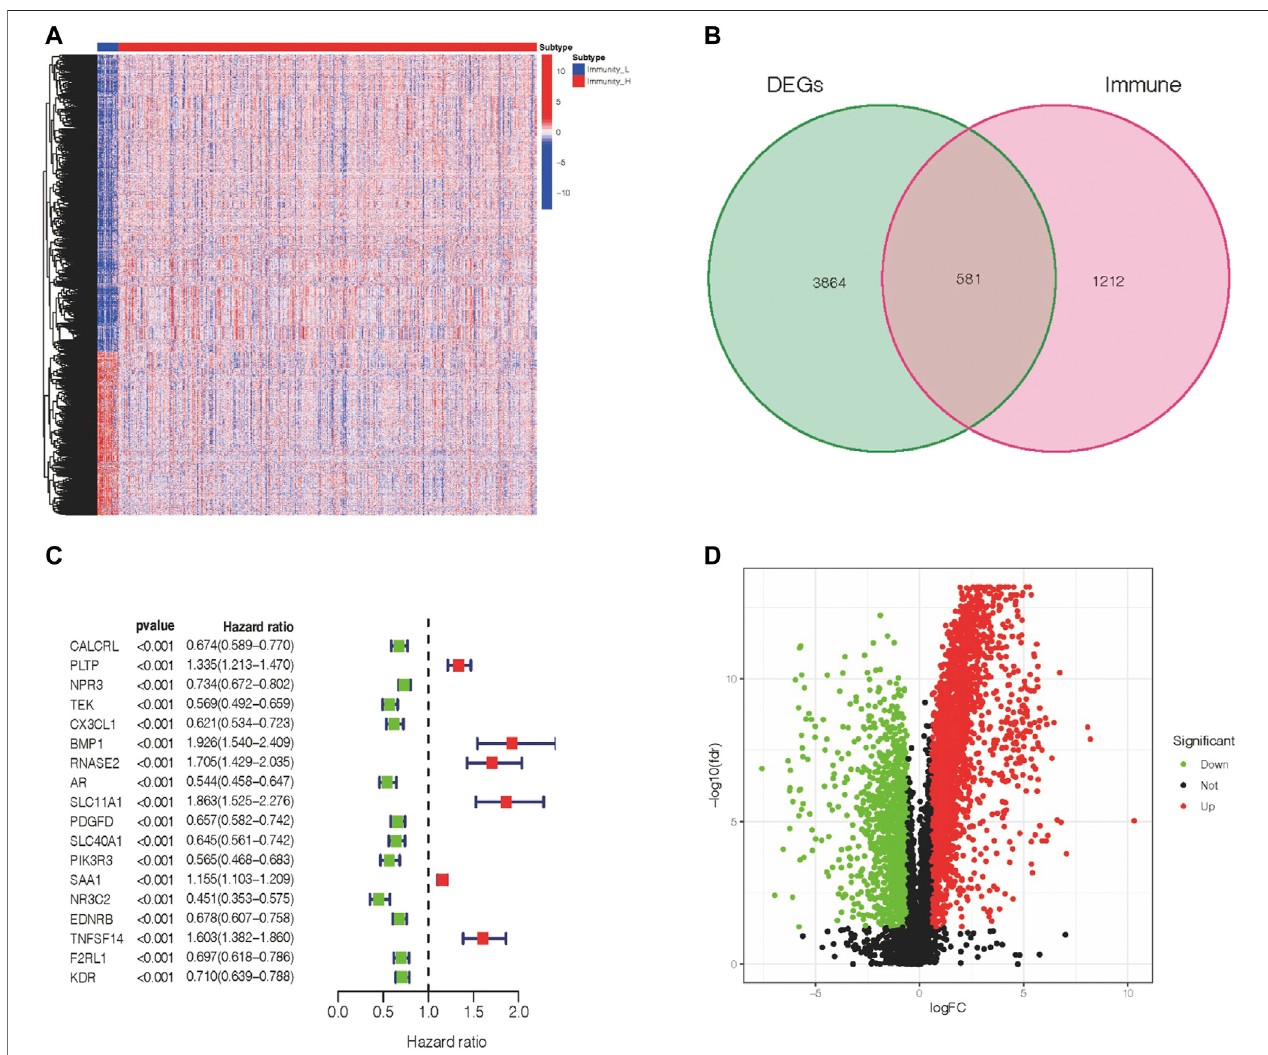
FIGURE 2 | Expression of DEGs and association with the clinical outcome. (A) Differentially expressed genes within two immune groups. (B) Isolation of differentially expressed immune genes. (C) PIGs and their hazard ratios were displayed in the forest plot via univariable Cox proportional hazards analysis. (D) Fold change and the FDR value were displayed in the volcano